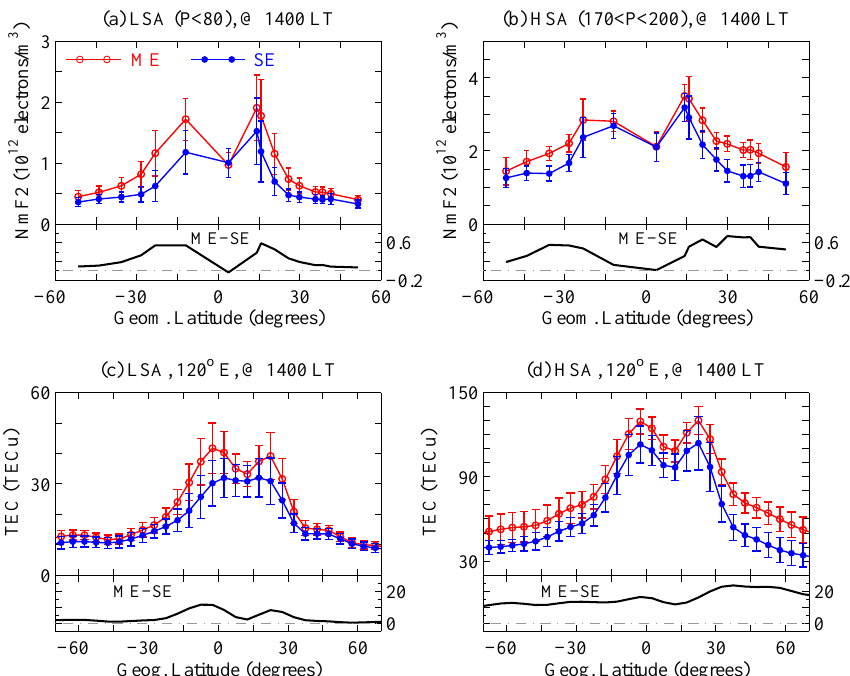
Fig. 1. Latitudinal variations of equinoctial noontime ( a and b ) Nm F2 in the East Asia/Australia sector and ( c and d ) TEC at 120 ◦ E at low solar activity (LSA) and high solar activity (HSA). Circles and dots show mean values and error bars show standard deviations, black lines in each bottom panel are the (ME-SE)